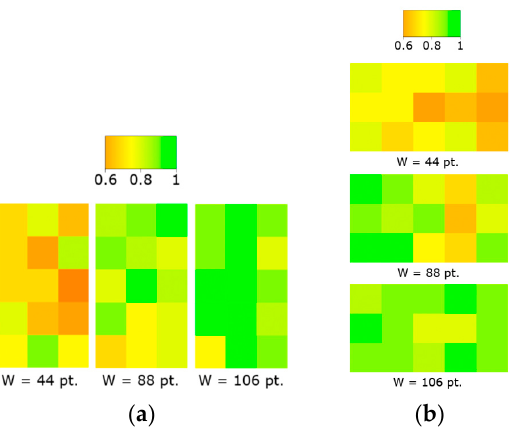
Figure 9. Correct selection rate by target width and with 1-gain condition for ( a ) portrait orientation and ( b ) landscape orientation. and ( b ) landscape